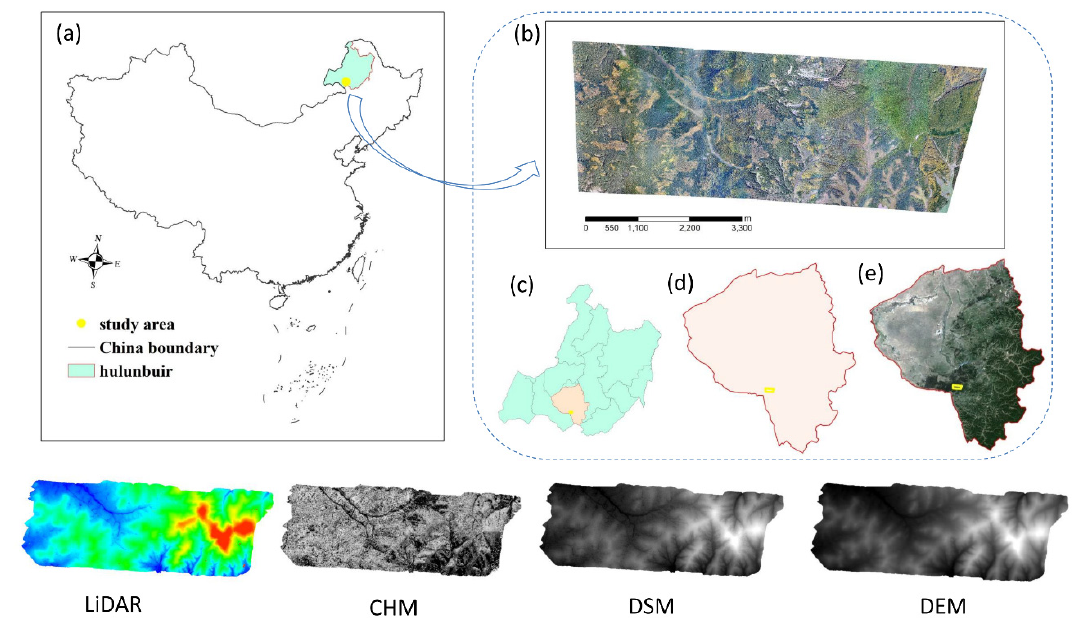
Figure 1. Methodological workflow of FCC estimated. This contains five steps: data preprocess treetop detection, tree-crown delineation, FCC estimation, and accuracy evaluation. This study focuses on six cases involving two tree species, namely camphor and white birch, and three de- grees of stands densities, namely sparse area, medium area, and dense area.